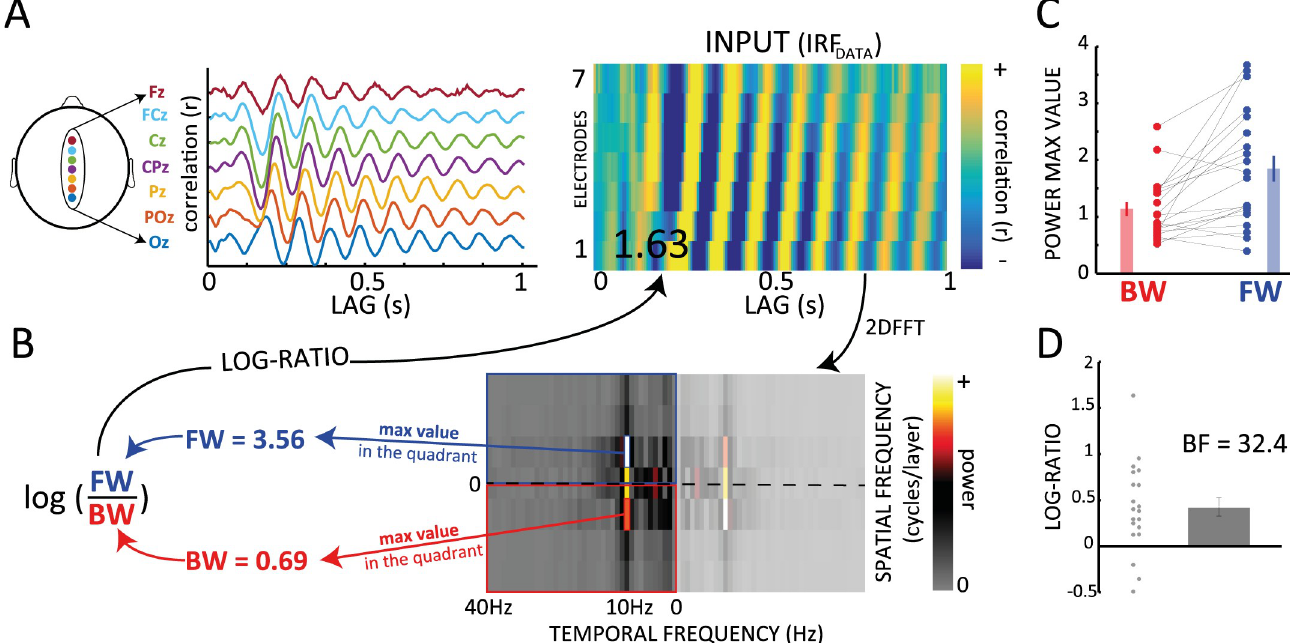
Fig 2. Alpha-band traveling waves in EEG IRFs. (A-B) IRF as traveling waves can be observed over the 7 midline electrodes of the 10–20 system (Oz to Fz; 1 representative subject). From the 2D map obtained by stacking signals from the 7 electrodes, we compute a 2D FFT and derive a log ratio between spectral quadrants that quantifies the direction of the waves. Positive values are associated with FW waves and negative values with BW ones. (C) BW (red) and FW (blue) values (max value in the corresponding quadrant of the 2D FFT) computed over 20 subjects. Participants were watching a white-noise luminance sequence (see Fig 1A). (D) Log ratios computed from the values in (C). The BF of a 1-sample t test against zero confirms the presence of FW waves. See S1 Data. BF, Bayes factor; BW, backward; EEG, electroencephalography; FFT, fast-Fourier transform; FW, forward; IRF, impulse response function.